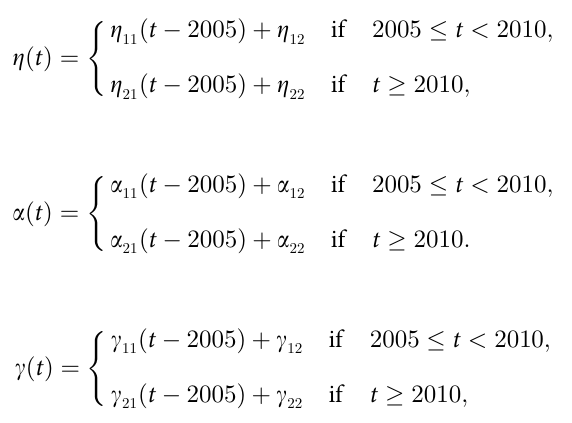
With the implementation of the Four Frees and One Care program in 2003, the Chinese government had rapidly scaled up HIV testing and ART, which was reflected by an increase in the number of HIV tested people and in the number of treatment centers. The surveillance data for Guangxi Zhuang Autonomous Region is available from the year 2005. The 5-year Guangxi AIDS Conquering Project (GACP) was launched from 2010. To correctly adjust for the increase in new HIV testing and ART, we use a time-dependent prevention rate η ( t ), diag- nosis rate α ( t ), ART enrolment rate γ ( t ) and model them by continuous piecewise linear func- tions. We assume that